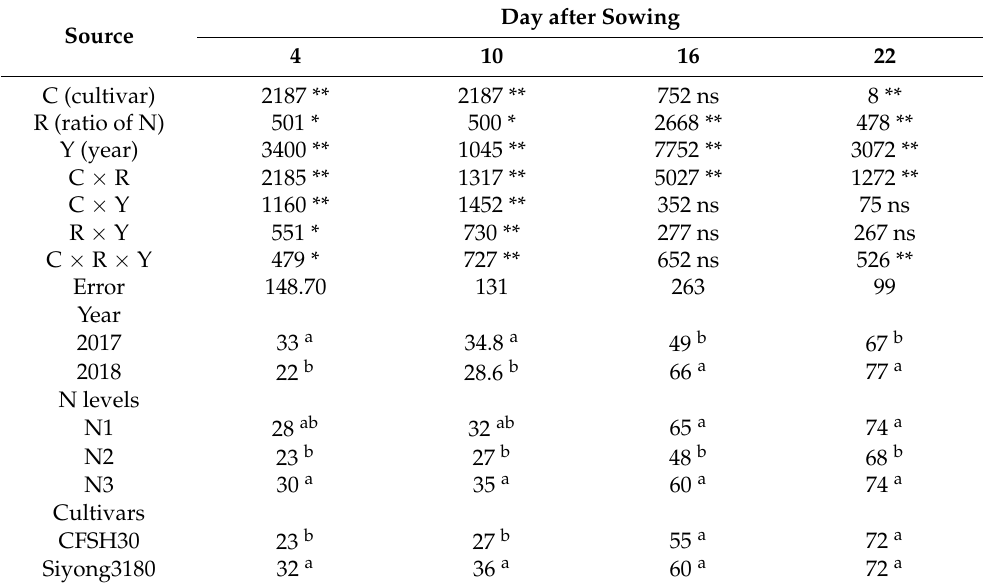
Table 1. Significance test for source of variation (mean square), and their effects on germination percentage 4, 10, 16, and 22 days after sowing during 2017 and 2018. Day after Sowing Source